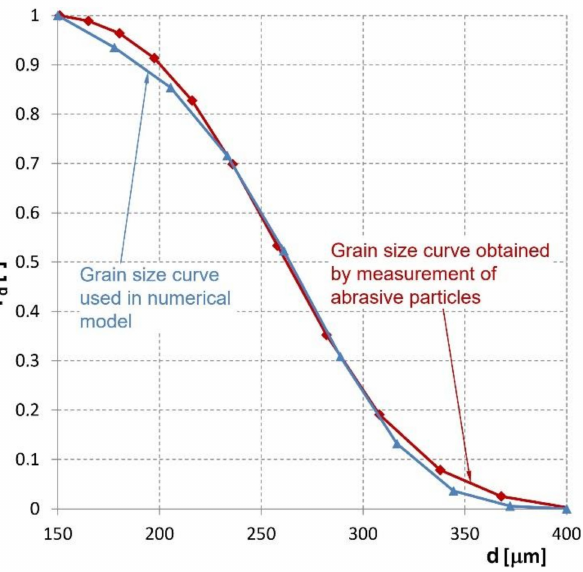
Figure 4. Comparison of the abrasive grain size curves obtained by measurement and the grain size curve used in the numerical